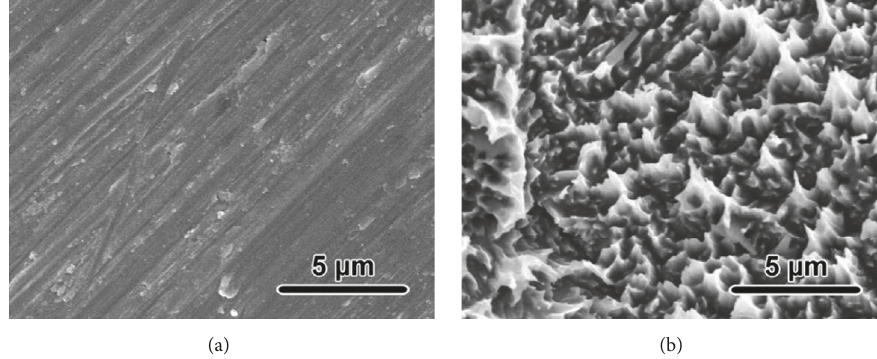
Figure 2: Surface morphology of specimens before and after pretreatment: (a) sandpaper polished; (b) acid etched specimens.